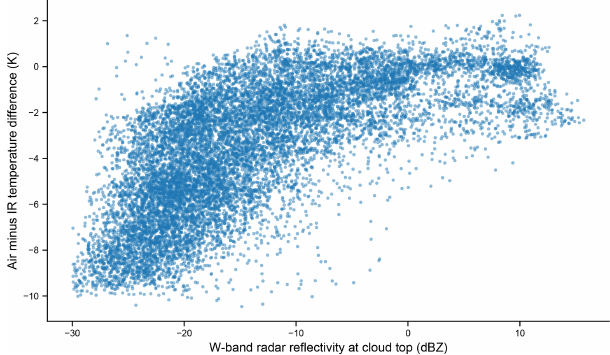
Figure 11. Difference between air temperature at cloud top T air ct and the observed IR temperature T IR ct as a function of W-band radar reflectivity at cloud top for the entire flight made on 19 Jan- uary 2020. The height of the cloud top is determined as the closest position to the observing aircraft at which the radar signal-to-noise ratio exceeds 14dB; air temperature as a function of height is de- termined from in situ samples made by the aircraft. Temperature differences near zero indicate that the clouds are optically thick in the